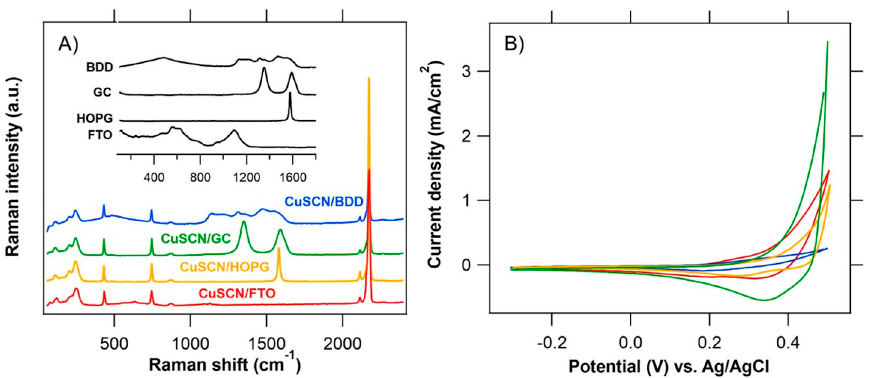
Figure 2. Raman spectra ( A ) and cyclic voltammograms ( B ) of CuSCN layers electrodeposited on (i) boron-doped diamond (CuSCN/BDD, blue trace), (ii) glass-like carbon (CuSCN/GC, green trace), (iii) highly ordered pyrolytic graphite (CuSCN/HOPG, yellow trace) and (iv) FTO glass (CuSCN/FTO, red trace) substrate. The reference Raman spectra of bare substrates are shown in black. The spectra are excited by 514 nm laser radiation and offset for clarity. The electrolyte solution used in chart B was 0.5 M KCl sat. CuSCN, scan rate was 100 mV/s.